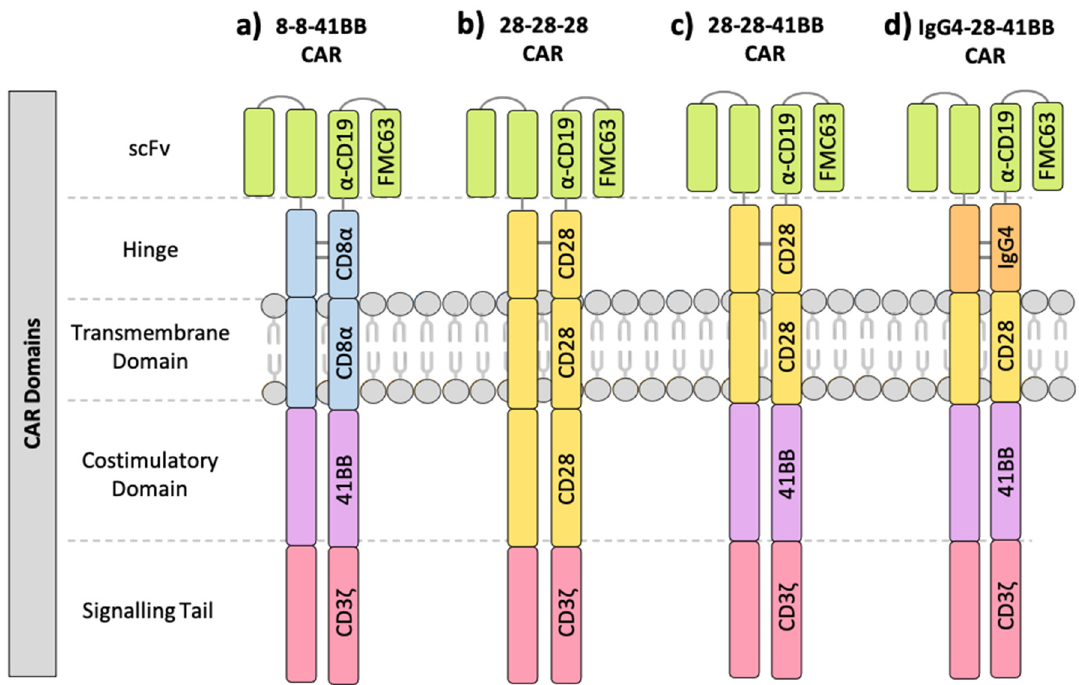
Figure 1. Structural domains of our main FMC63 anti-CD19 CARs. The structural design of the ( a ) 8-8-41BB CARs, ( b ) 28-28-28 CARs, ( c ) 28-28-41BB CARs and ( d ) IgG4-28-41BB CARs reviewed here. The individual scFv, hinge, transmembrane domain, costimulatory domain and signalling tails are labelled. Horizontal lines between hinge domains indicate disulfide bonds.